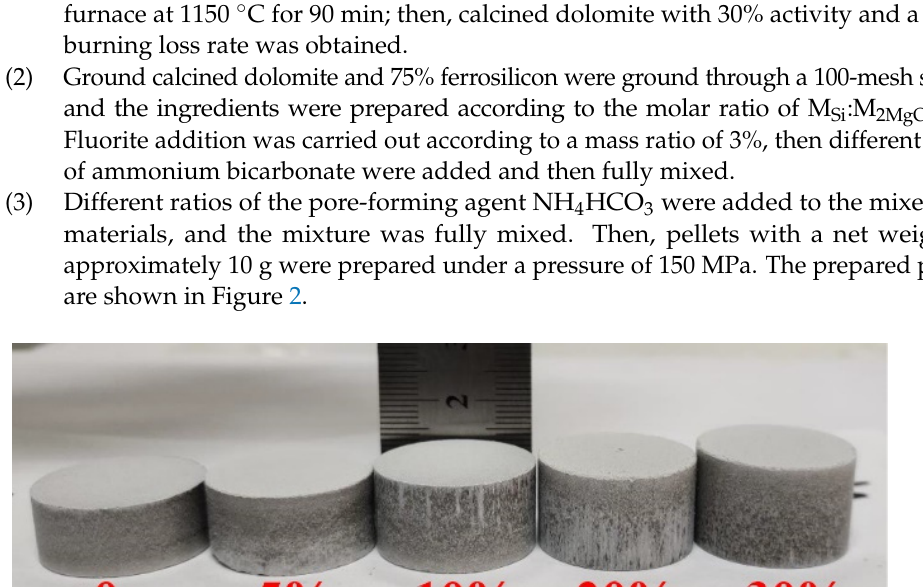
Figure 1. The craft of pellet preparation.